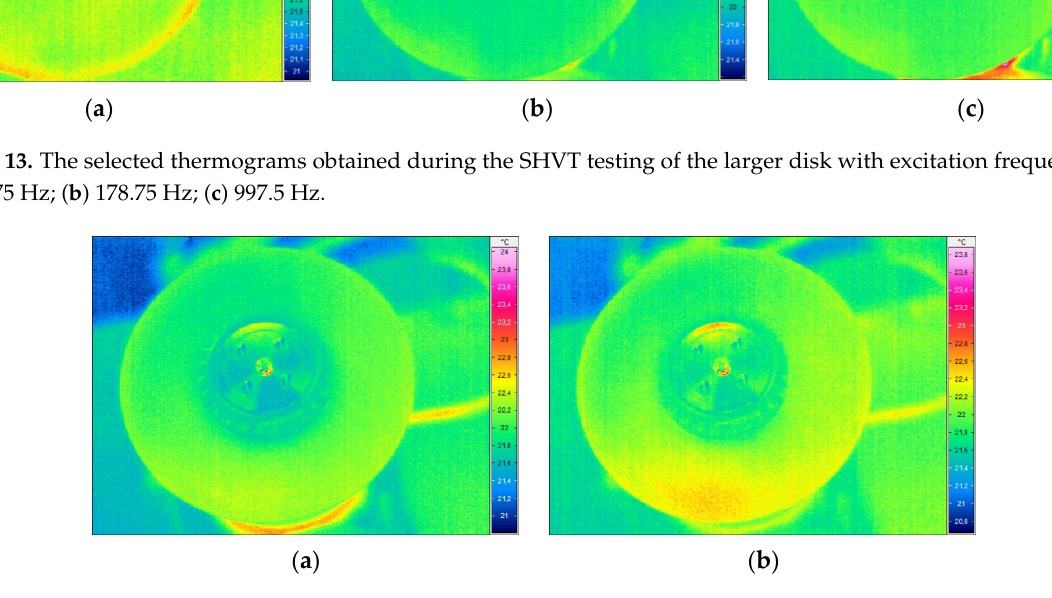
Figure 14. The selected thermograms obtained during the SHVT testing of the smaller disk with excitation frequencies of ( a ) 1106 Hz; ( b ) 1170 Hz.